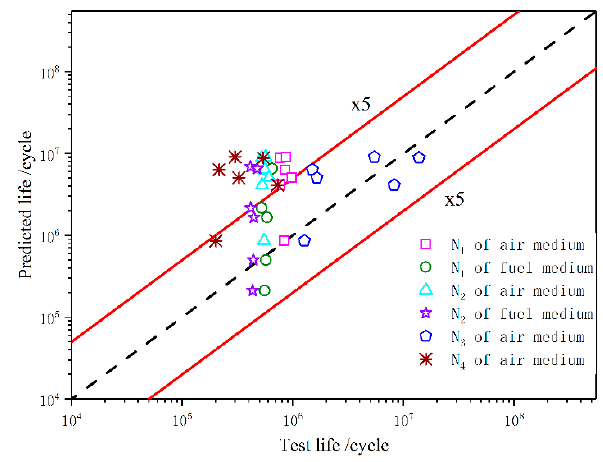
Figure 14. Real life and predicted life of the specimens.